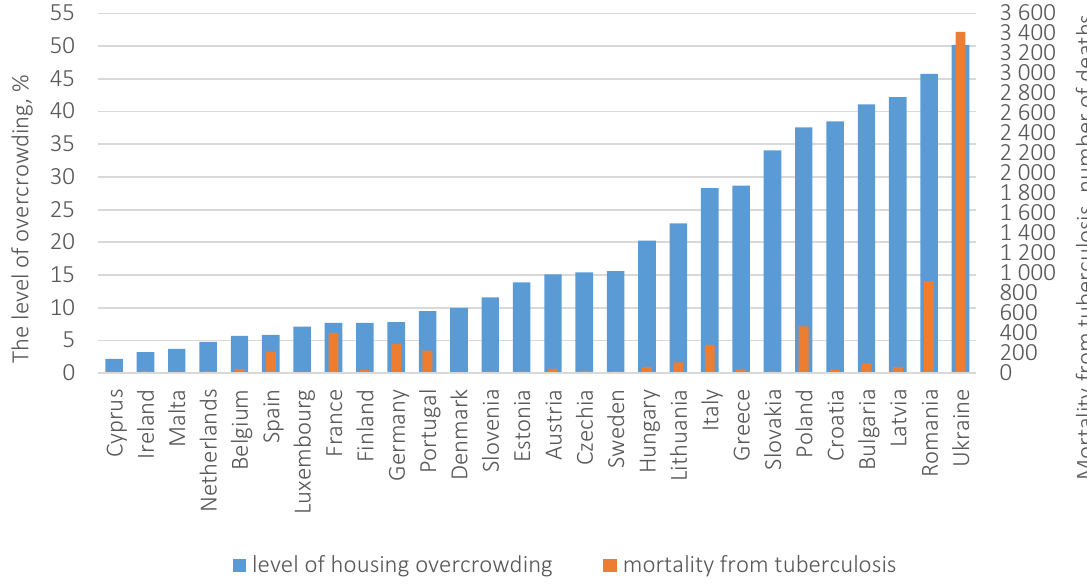
Figure 3. Comparative analysis of the EU countries and Ukraine in terms of overcrowding and mortality from tuberculosis in 2019